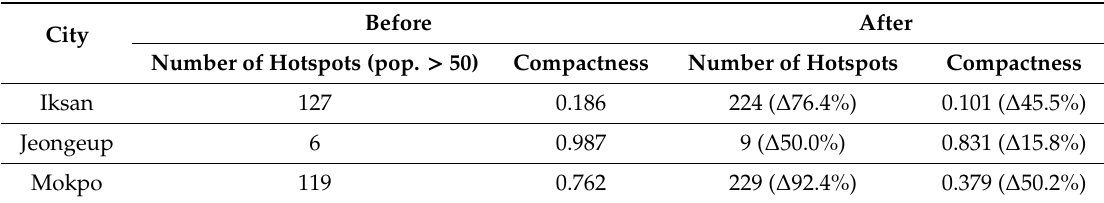
Table 6. Number of hotspots and compactness in the HSR station catchment